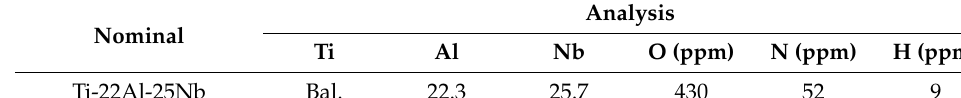
Table 1. Chemical composition of the as-received alloy (at.%).